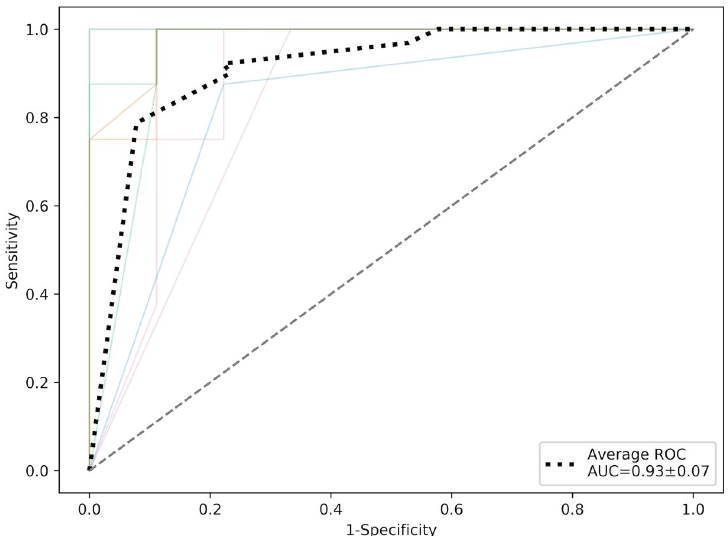
Patients with a KRT81+ ( high risk ) radiomic signature experienced diminished disease-free and overall survival. Over the 10 cross-validation folds, the median hazard ratio for patients with a high risk vs. a low risk radiomic signature was 3.08 [range 0.46 to 3.37] for disease-free and 3.04 [range 0.27 to 3.36] for overall survival. The radiomics-derived stratification led to a